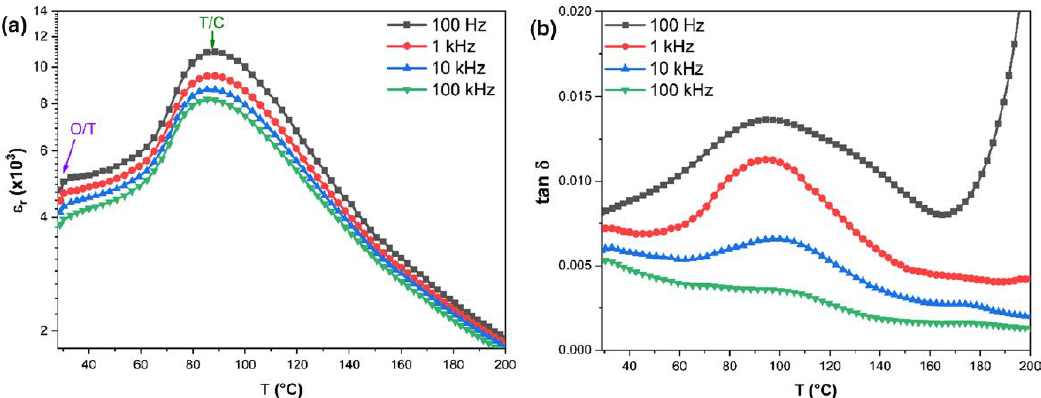
Figure 4. Temperature-dependence of the ( a ) dielectric constant and ( b ) dielectric loss of Ba (1- x) Ca x Zr y Ti (1-y) O 3 (BCZT) ceramic at different frequencies. O/T corresponds to orthorhombic – tetragonal transition and T/C denotes the tetragonal – cubic phase transition. Reprinted with permission from [55]. Copyright 2019 Springer Nature.